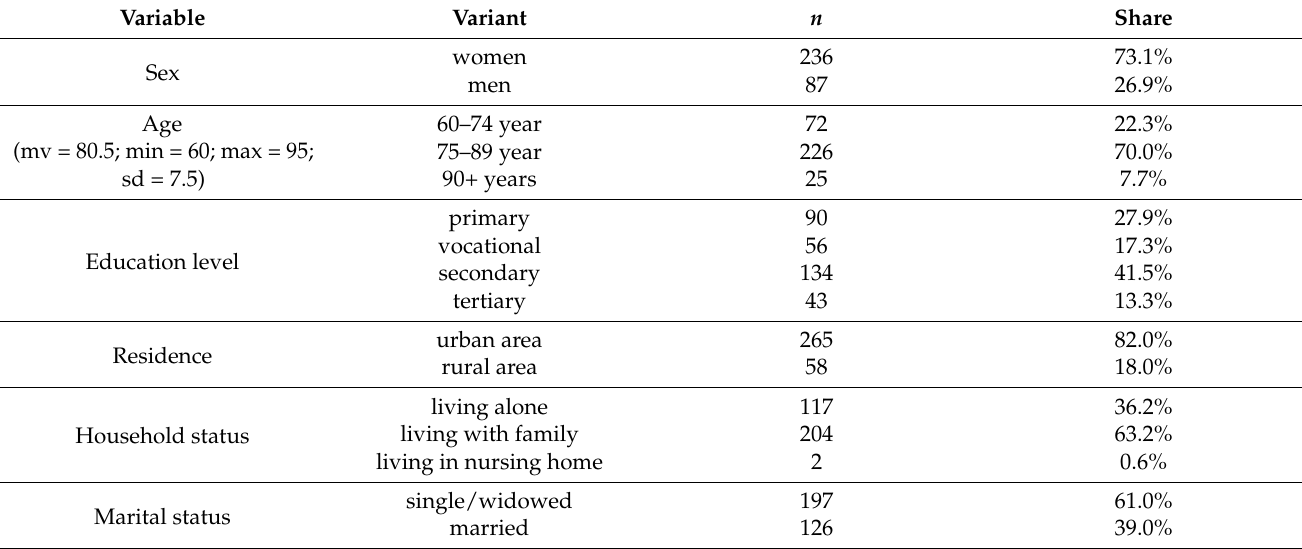
Table 1. Sociodemographic characteristics of the study